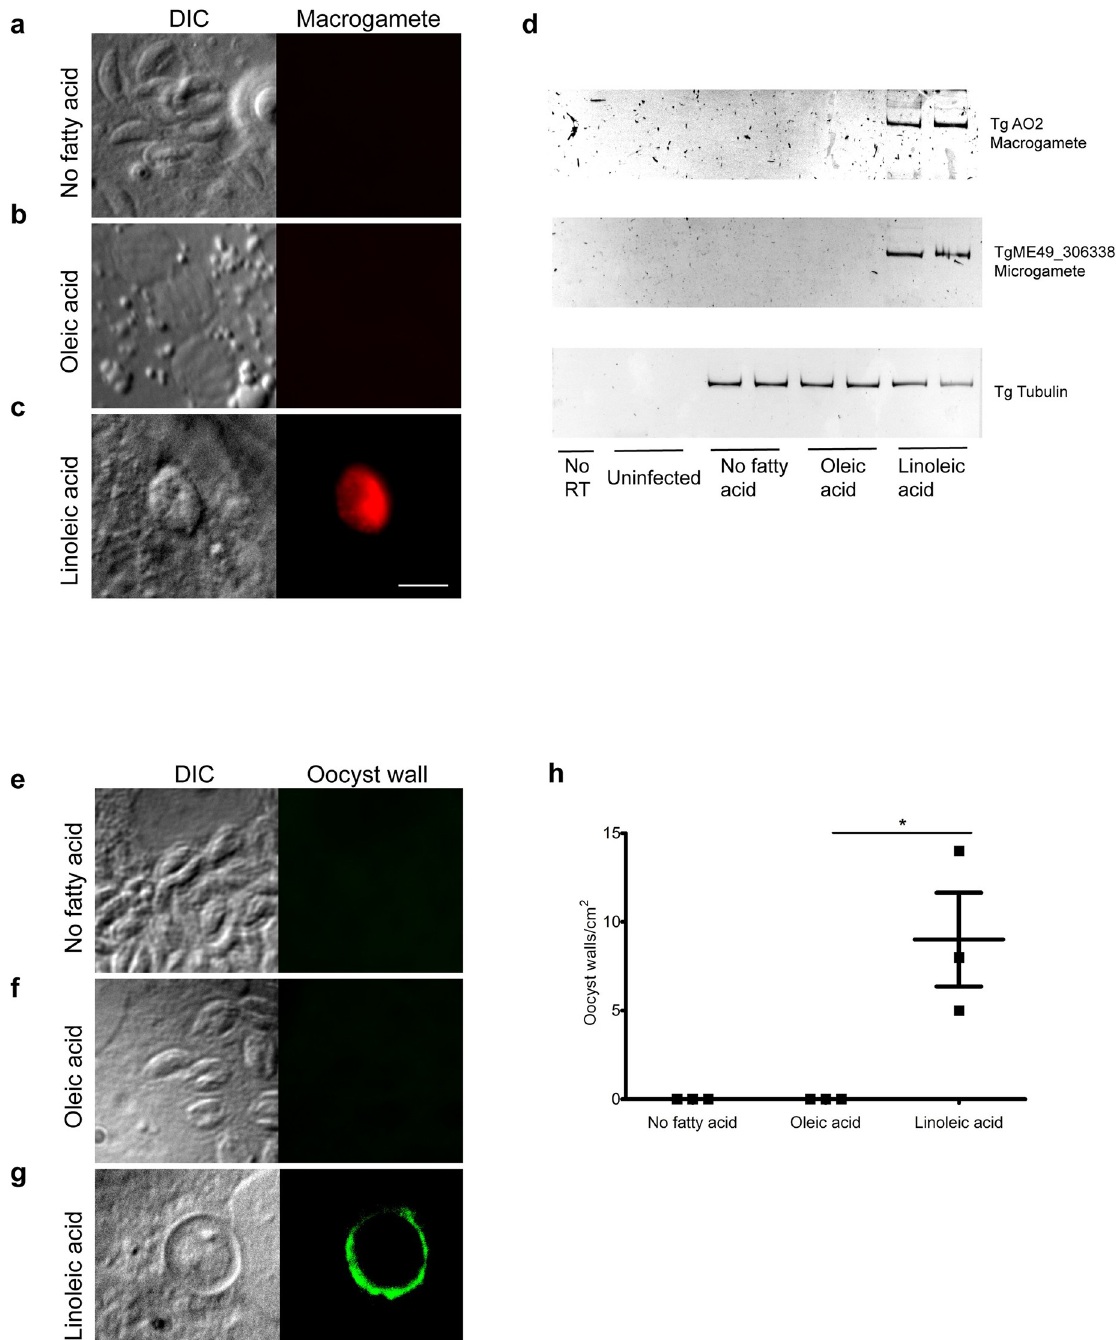
Fig 3. Identification of gametes and intracellular oocysts in cat tissue culture. Cat intestinal organoids were disassociated by trypsin and then grown as monolayers on glass slides. Monolayers were grown to confluency and then were incubated with either no fatty acid supplementation (a and e), 200 μ M oleic acid (b and f), or 200 μ M linoleic acid (c and g) for 24 hours and infected with ME49 bradyzoites purified from brains of chronic infected mice. After 7 days, monolayers were incubated with mouse anti-AO2 (a–c) or mouse monoclonal IgM 3G4 (e–g). The amiloride-sensitive AO2 is an enzyme exclusively expressed in macrogametes and early oocysts and has a possible role in oocyst wall biogenesis [10]. AO2 expression was only detected by immunofluorescence in the monolayers supplemented with linoleic acid (c). 3G4 is a mouse monoclonal antibody produced by immunizing mice with purified oocyst walls [11]; thus, it is a marker of oocyst wall biogenesis. Only monolayers supplemented with linoleic acid (g) had positive 3G4 vacuoles. All panels are 20 μ m 2 with a 5- μ m white size bar in the lower right corner. (d) Markers for macrogamete and microgamete expression were also evaluated by PCR. Cat intestinal monolayers